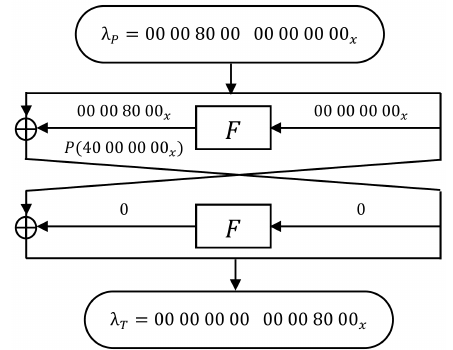
Figure 11: Two-Round Iterative Linear Approximation ( λ 7